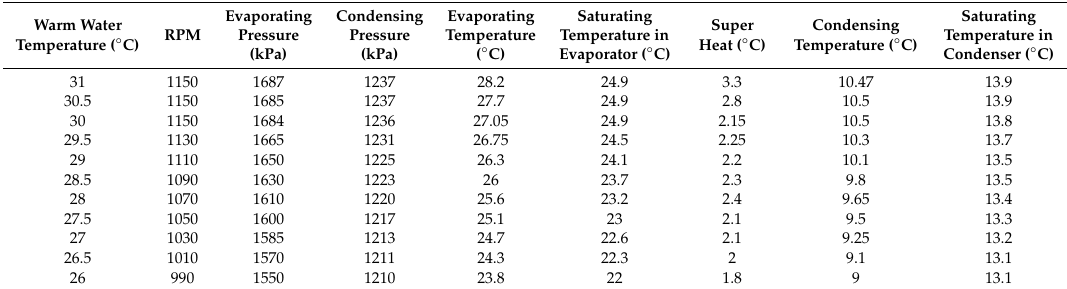
Figure 5. Flow chart of dynamic OTEC for PID control and implementation of the PID-A equation: ( a ) flow chart; ( b ) PID-A equation from Honeywell. Table 2. Operating fluid pump RPM control range according to the surface water temperature (cold water temperature: 5.5 ◦ C).